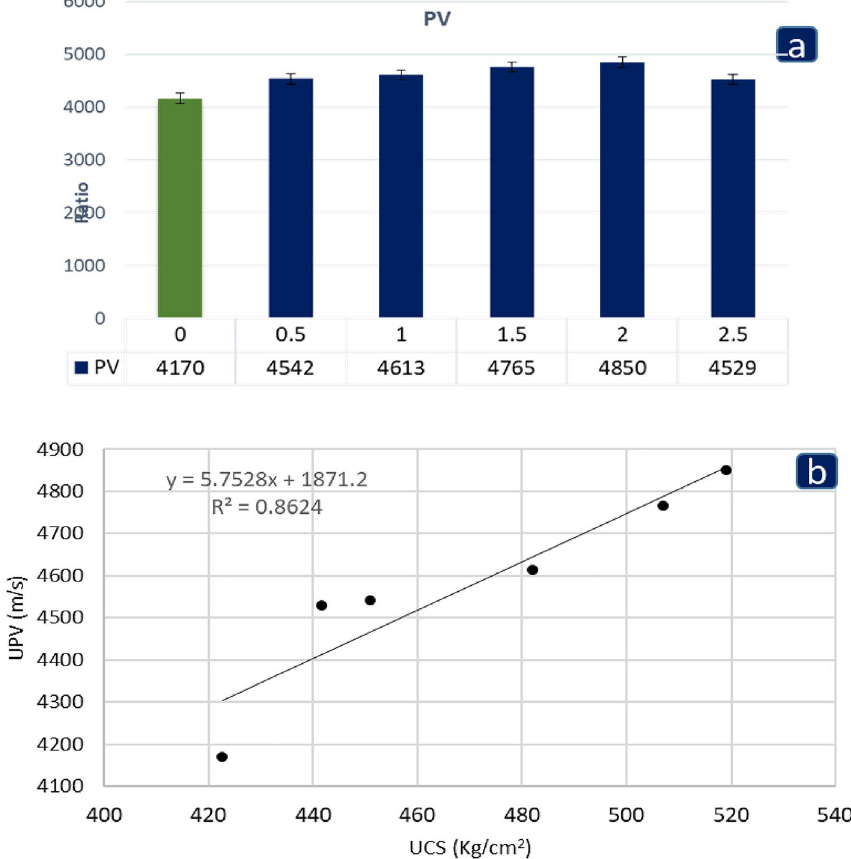
Figure 7. ( a ) P-wave velocity results after 28 days and ( b ) the relationship between UCS and PV for concrete containing HPPM.